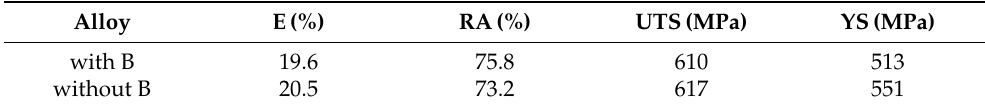
Table 2. Elongation (E), reduction in area (RA), ultimate tensile strength (UTS), and yield strength (YS) of the studied alloys at room temperature. Alloy E(%) RA(%) UTS(MPa) YS(MPa) with B 19.6 75.8 610 513 without B 20.5 73.2 617